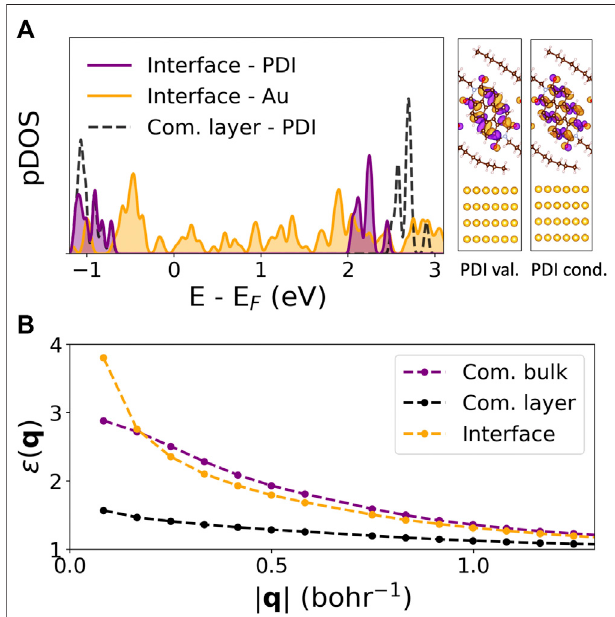
FIGURE 3 | Quasiparticle and dielectric properties of the C8-PDI@Au interface: (A) GW pDOS on C8-PDI (purple) and Au (orange) atomic orbitals, compared to the freestanding molecular layer (dashed black). The right panel shows the electronic distributions of the PDI-localized valence and conduction states. (B) Computed GW dielectric function, ε ( q ), for the commensurate bulk (purple), commensurate layer (black), and the interface structure